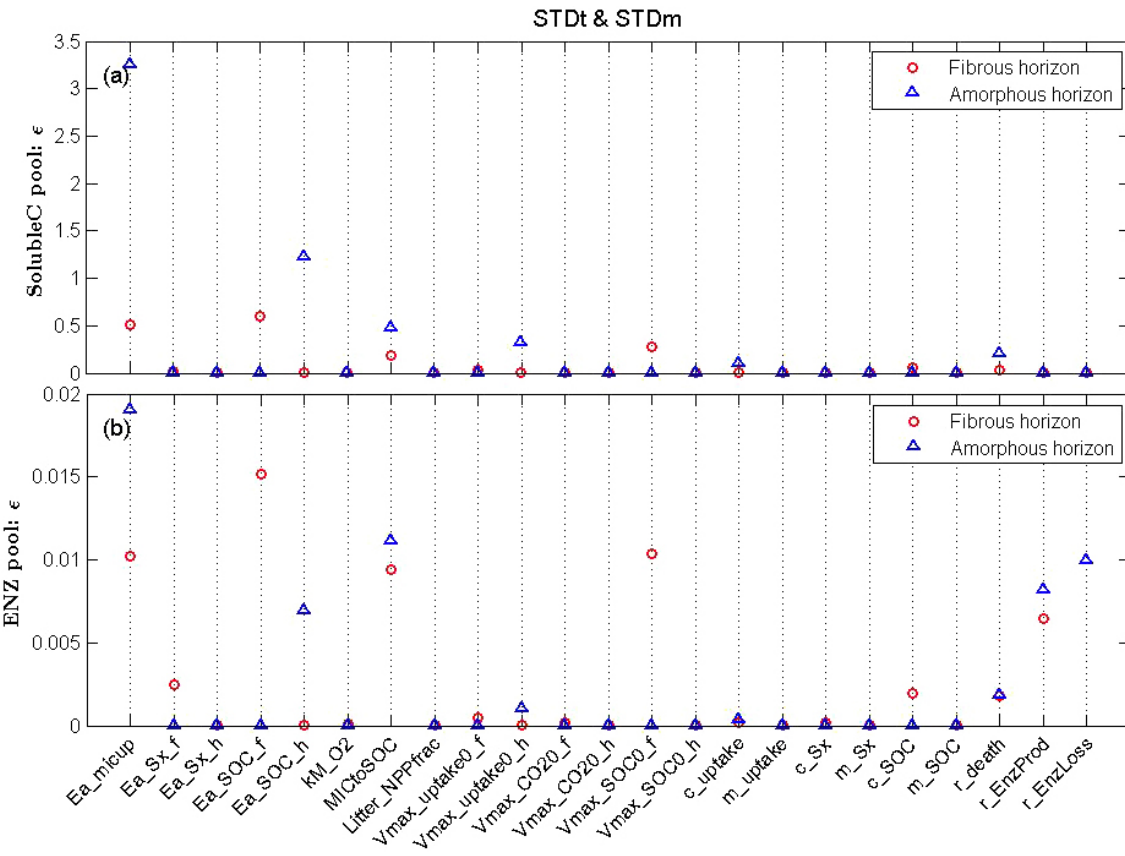
q + σ 2 µ ∗ ) for (a) soluble C pool (Soluble C) and (b) enzyme pool (ENZ) under a EE EE 2